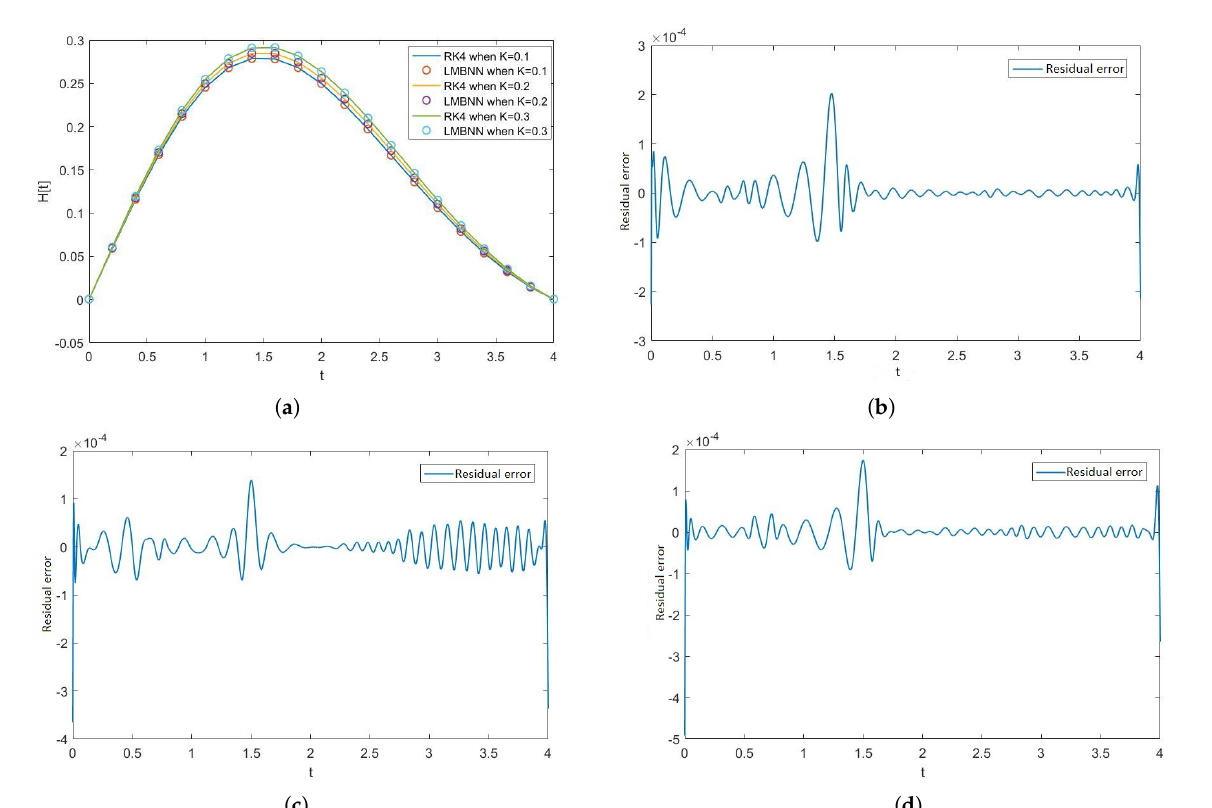
Figure 6. Graphical illustration of the effect of rotation parameter K on H and graphical illustration of error in the output data obtained through RK4 and LMBNN of H. ( a ) Graphs of H when K varies. ( b ) Error in H when K = 0.1. ( c ) Error in H when K = 0.2. ( d ) Error in H when K =